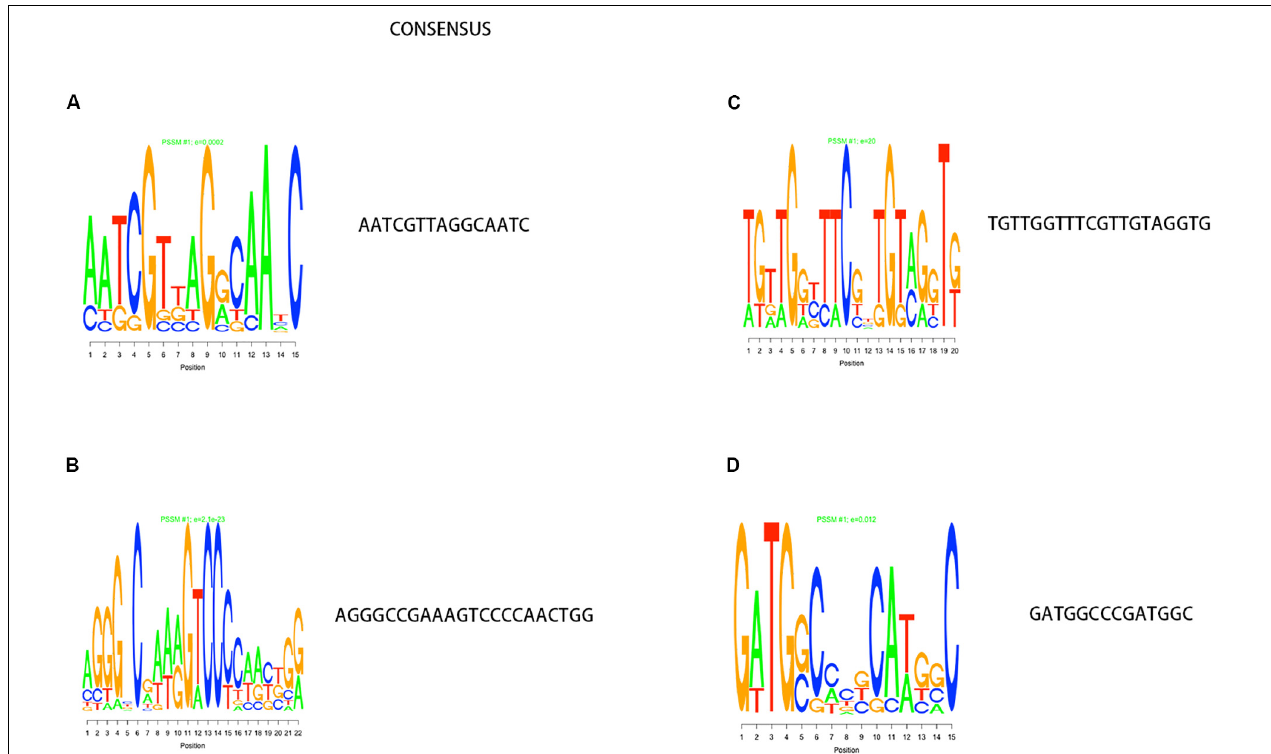
FIGURE 4 | Motif analysis results with the largest number of cell wall genes in a single module cluster. (A–D) The motif base distribution of the four modules with the largest number of cell wall genes. In each BP base distribution in the motif, the size of the base is proportional to the corresponding frequency.